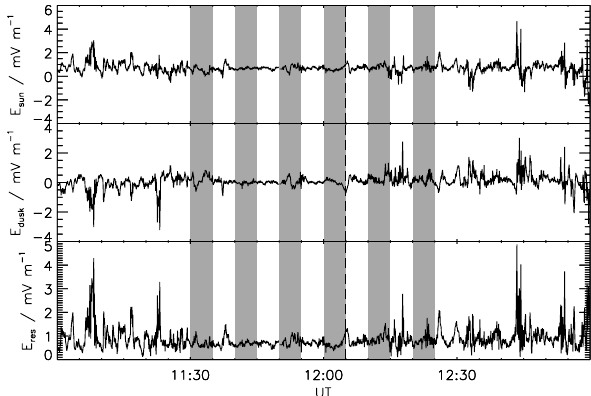
Figure 7 Fig. 7. Electric field measurements in mVm − 1 made by Cluster-2 EFW experiment during 11:00–13:00UT on 1 February 2006. The sunward and duskward components plotted in the top and middle panels, respectively, correspond to GSE X and Y. Their resultant ([ E 2 + E 2 sun ] 1 / 2 ) is plotted in the third panel. The grey shaded dusk regions indicate the 5min SPEAR on times, and the vertical dashed lines mark the estimated time of closest approach of Cluster-2 to the SPEAR flux tube, as in Fig.